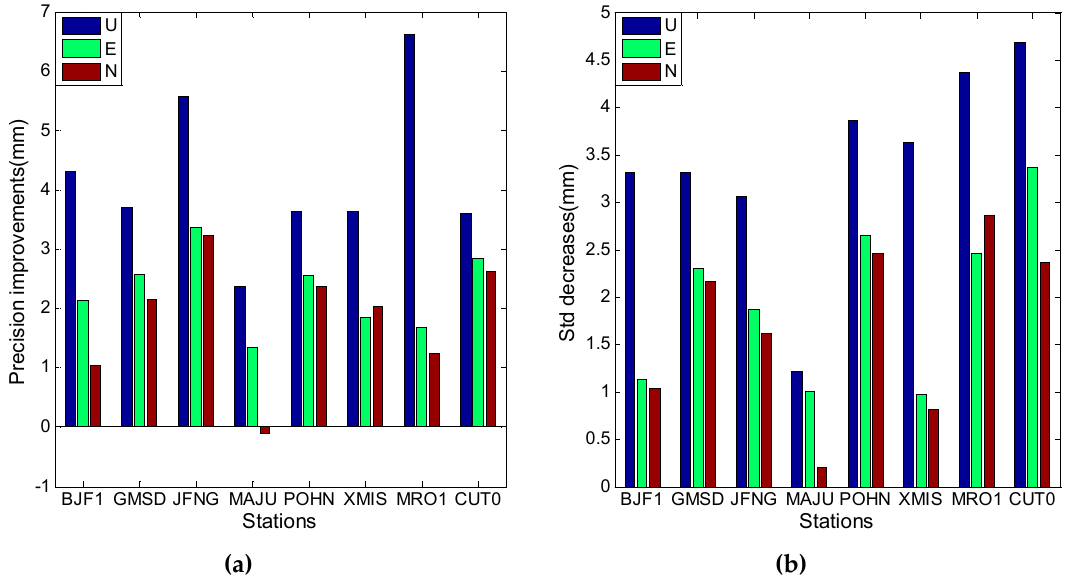
Figure 24. The kinematic PPP results using ionosphere-free combination of the first and third frequencies. ( a ) Describes the precision improvements after the model is applied; ( b ) Describes the std decreases after the model is applied.